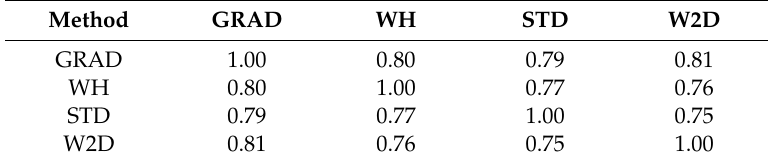
Table 7. Inter-comparison of the ML heights (m) determined by di ff erent methods for winter sunny days of 2013.